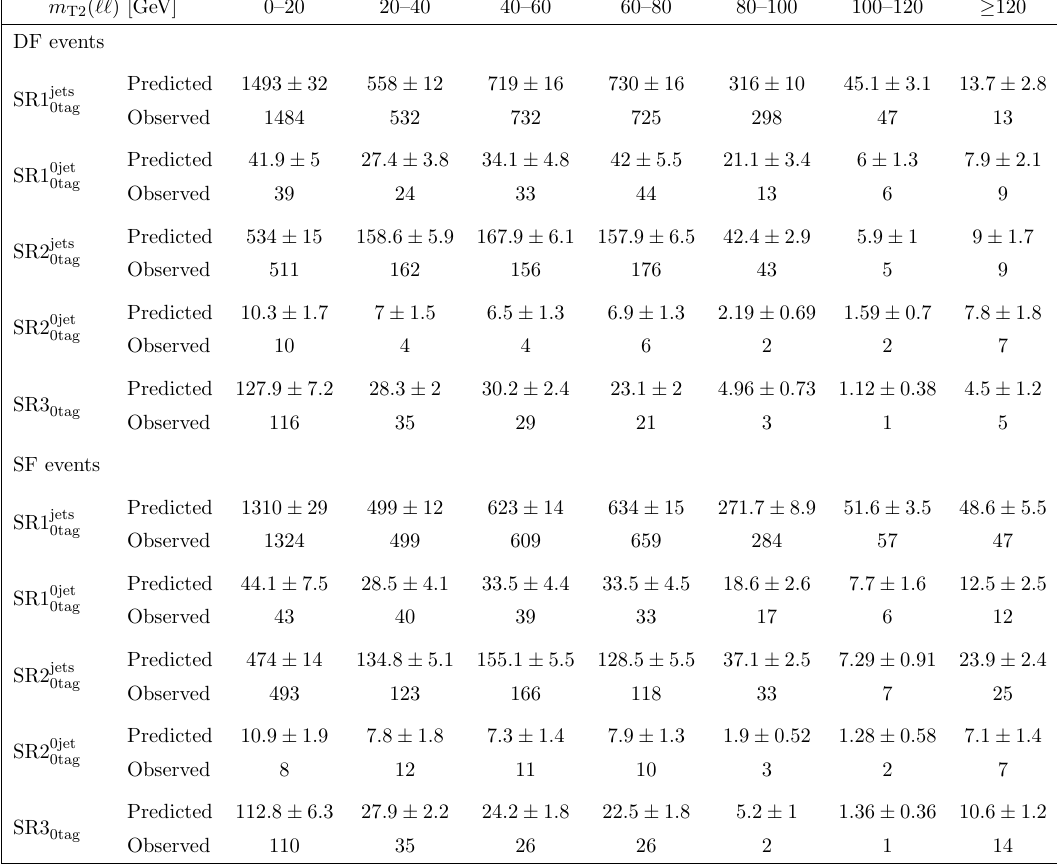
Table 7 . Observed and expected yields of DF (the upper half of table) and SF (the lower half) events in the SRs for the chargino search. The quoted uncertainties in the background predictions include statistical and systematic